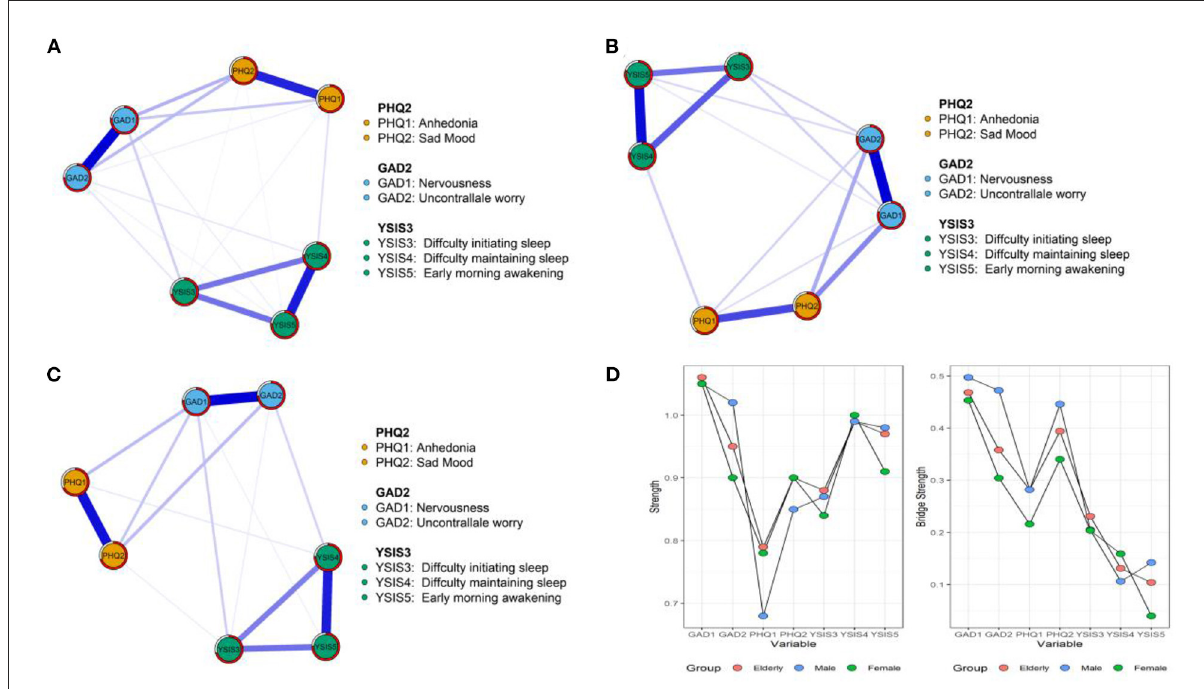
FIGURE1 The network structures of anxiety, depressive symptoms, and sleep quality. (A) All elderly. (B) Male elderly. (C) Female elderly. (D) Strength and bridge strength values.